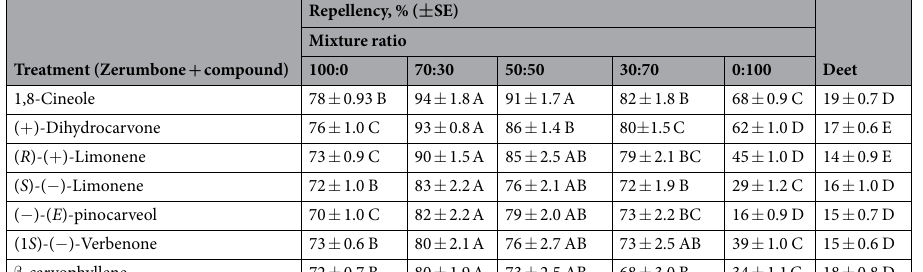
Treatment (Zerumbone + compound)